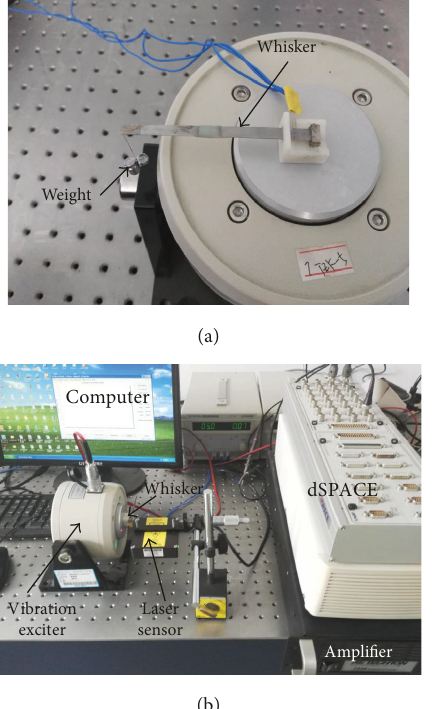
Figure 2: Experimental system for (a) static bending test and (b) vibration test.